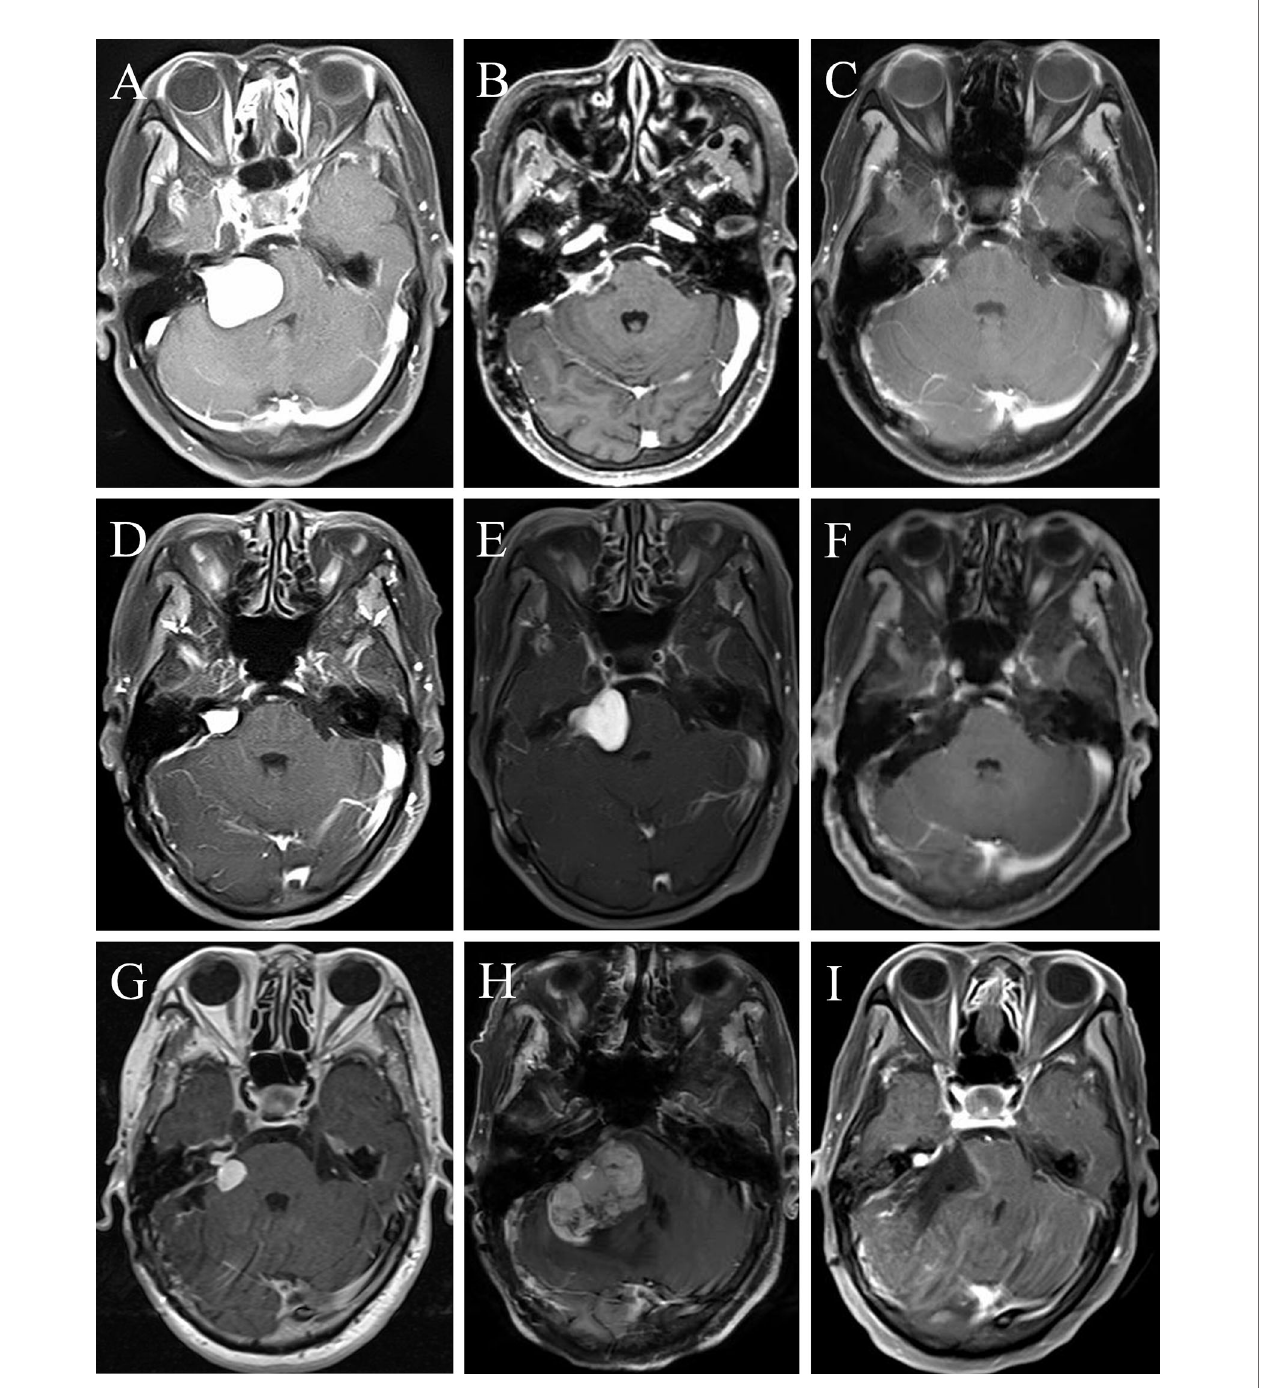
FIGURE 5 | A female MTVS patient underwent multiple operations and radiotherapy with a 40 months ’ survival time. Case 2. Preoperative contrast-enhanced magnetic resonance image (MRI) (A) of a 64-year-old female depicted a homogeneously enhanced tumor located at right cerebellopontine angle (CPA). After a NTR, enhanced MRI 3 months postoperatively (B) showed a remnant tumor and gamma knife radiosurgery (GKS) was conducted. Eight months after GKS, the tumor showed slight shrink on contrast-enhanced MRI (C) . However, enhanced MRI 2 years (D) and 2.5 years (E) after operation demonstrated regrowth of the tumor. She underwent the second operation and the pathological diagnosis was MPNST (WHO grade 3/FNCLCC grade 2). Postoperative MRI (F) con fi rmed gross total resection (GTR). Two years later, the tumor regrew again and GKS was prescribed (G) . One year later, the MPNST grew to a maximum size of 45mm with heterogenous enhancement (H) . The patient received the third operation and postoperative MRI (I) demonstrated tiny remnant tumor located at the roof of internal auditory meatus.